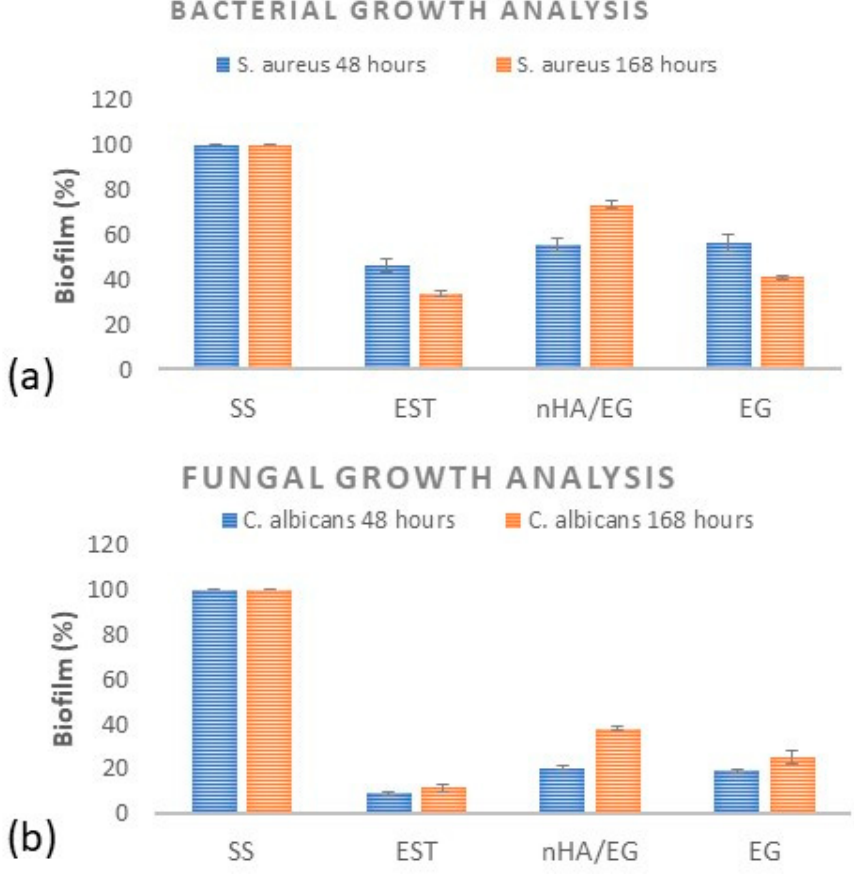
Figure 8. Rate of biofilm formation (( a ) S . aureus ( b ) C . albicans ) on processed orthodontic retainers and controls measured by counting colony-forming units (CFU) after incubation for 48 h and 168 h.